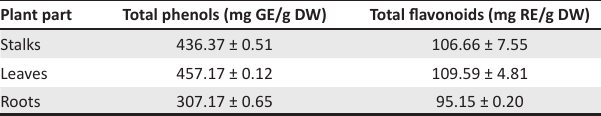
TABLE 3: Total phenolic and total flavonoid contents of Lantana trifolia extracts. Plant part